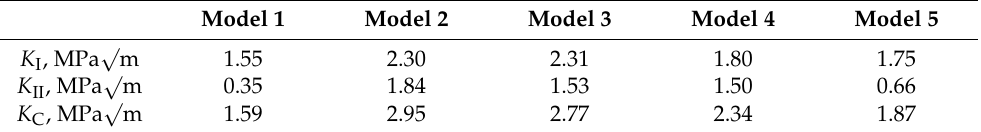
Table 2. Fracture toughness values for each model in the molecular dynamics (MD) simulation.